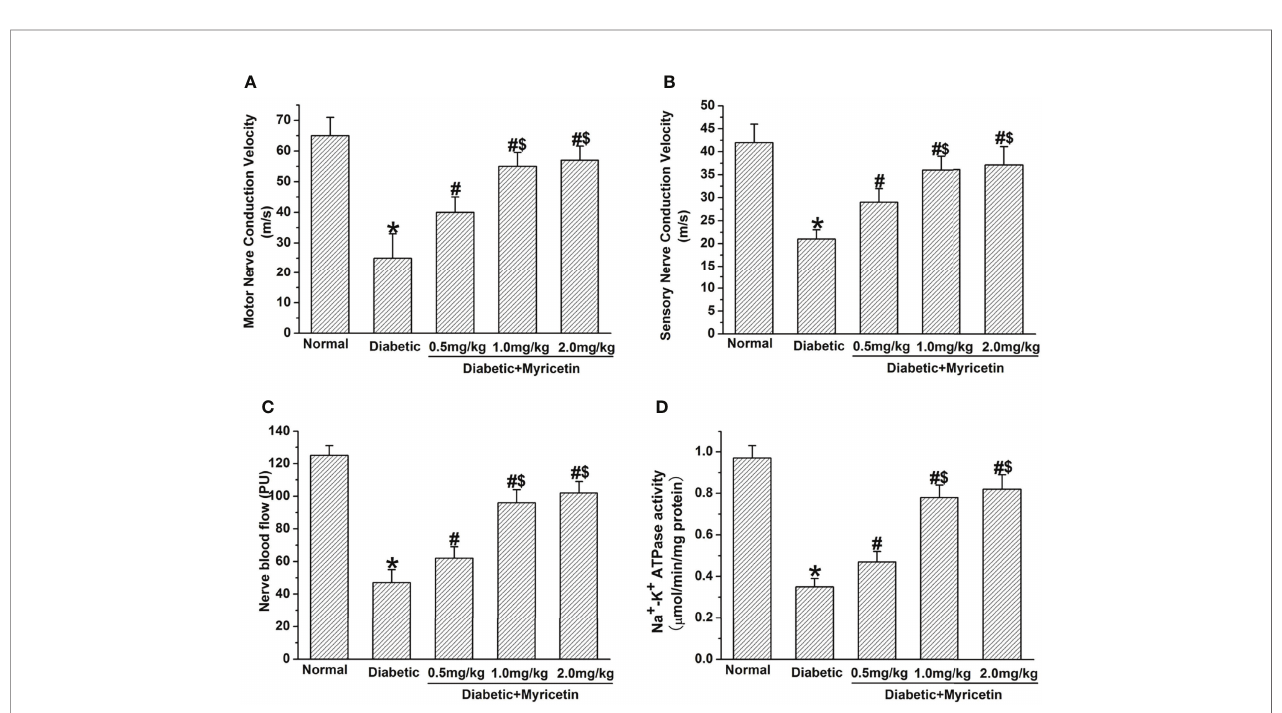
FIGURE 3 | The bene fi cial effect of myricetin on NCV, NBF, and Na + , K + -ATPase activity in diabetic rats ( n = 10 for each group). Myricetin signi fi cantly raised the amplitude of motor (A) and sensory (B) NVV, NBF (C) , and Na + , K + -ATPase activity (D) in diabetic rats. * p < 0.05 for the comparison to the normal group, # p < 0.05 for the comparison to the saline-treated diabetic rats. $ p < 0.05 for the comparison to the diabetic rats treated with myricetin at 0.5